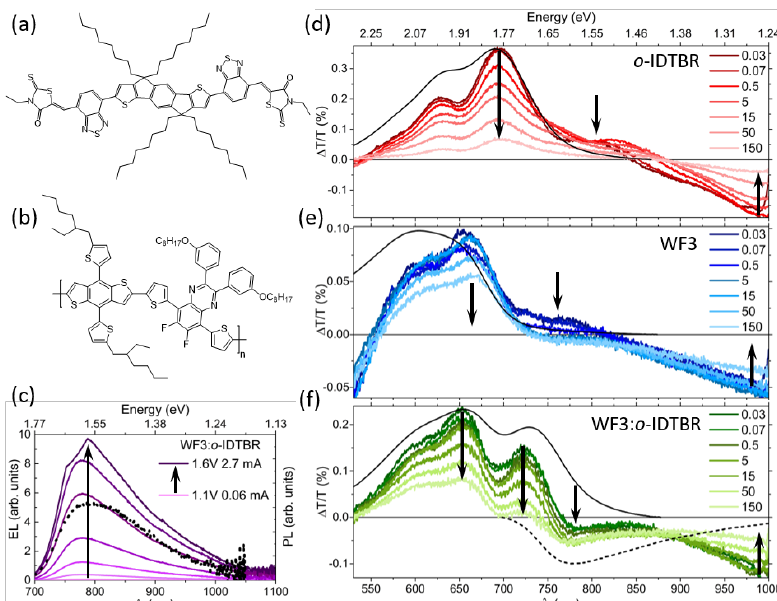
Fig. 1. Molecular structure of (a) o -IDTBR and (b) WF3. (c) EL of WF3: o -IDTBR bulk- heterojunction for different injected currents (solid lines), and PL of the bulk-heterojunction (black dots). (d) Sequence of chirp-corrected TA spectra of pristine o -IDTBR from 0.03 to 150 ps and linear absorption spectrum (black). (e) Same as (d) for WF3. (f) Same as (d) for the WF3: o - IDTBR blend. The dashed line in (f) is the electroluminescence multiplied by a negative scaling factor for comparison with the PIA band. The linear absorption spectra of o -IDTBR, WF3 and the blend are shown in solid black lines in Figures 1d, 1e and 1f respectively. In the blends the o -IDTBR peak at 690 nm is redshifted to 729 nm (775 cm-1 or 96 meV shift), suggesting that a different crystalline domain of the o -IDTBR is formed near the interface with the WF3, potentially involving wavefunction delocalization between them. One notable feature of the WF3: o -IDTBR devices is that they show electroluminescence (EL) quantum yields nearly two orders of magnitude higher than the typical values for polymers blended with fullerene acceptors (including WF3). In Figure 1c the EL spectrum of WF3: o -IDTBR for different injected currents is shown in shades of purple, and it matches the photoluminescence (PL) spectrum of the WF3: o -IDTBR (black dots in Fig. 1c). Thus, injecting either electrons or photons in the WF3: o -IDTBR bulk-heterojunction both trigger emission from the same NIR band, supporting the hypothesis that this band corresponds to an emissive charged state. Further, the PL of WF3: o -IDTBR is quenched compared to that of the pristine materials, suggesting that this charged state is localized at the interface, with the PL being quenched due to diffusion of most of the separated carriers into the donor and acceptor domains. Broadband transient absorption (TA) spectroscopy was performed using ≈10 fs excitation pulses with spectrum spanning from 525 to 730 nm generated with a noncollinear OPA, keeping the samples under nitrogen and pump intensities between 1 and 4 μ J/cm 2 to avoid bimolecular recombination kinetics [4]. In order to probe the spectral region of main interest (between 730 and 850 nm) continuously, we built a narrowband OPA at 1225